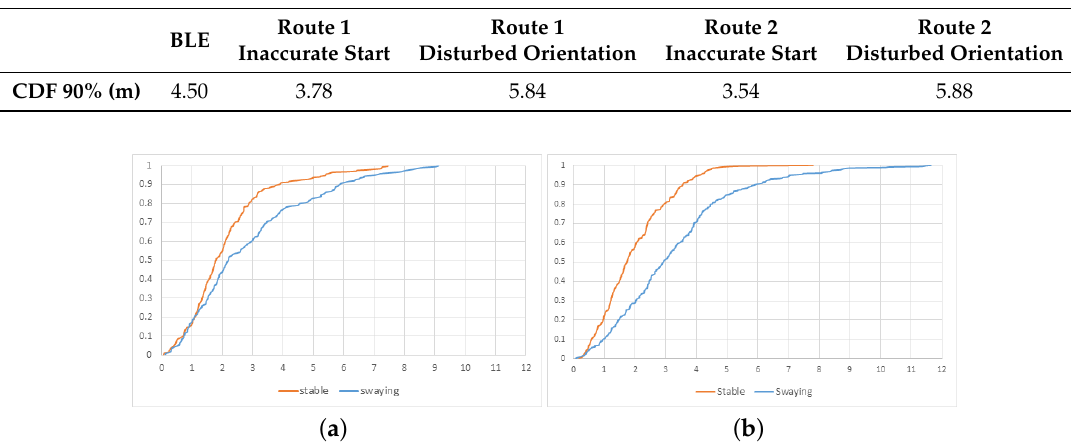
Table 4. CDF of the four cases.